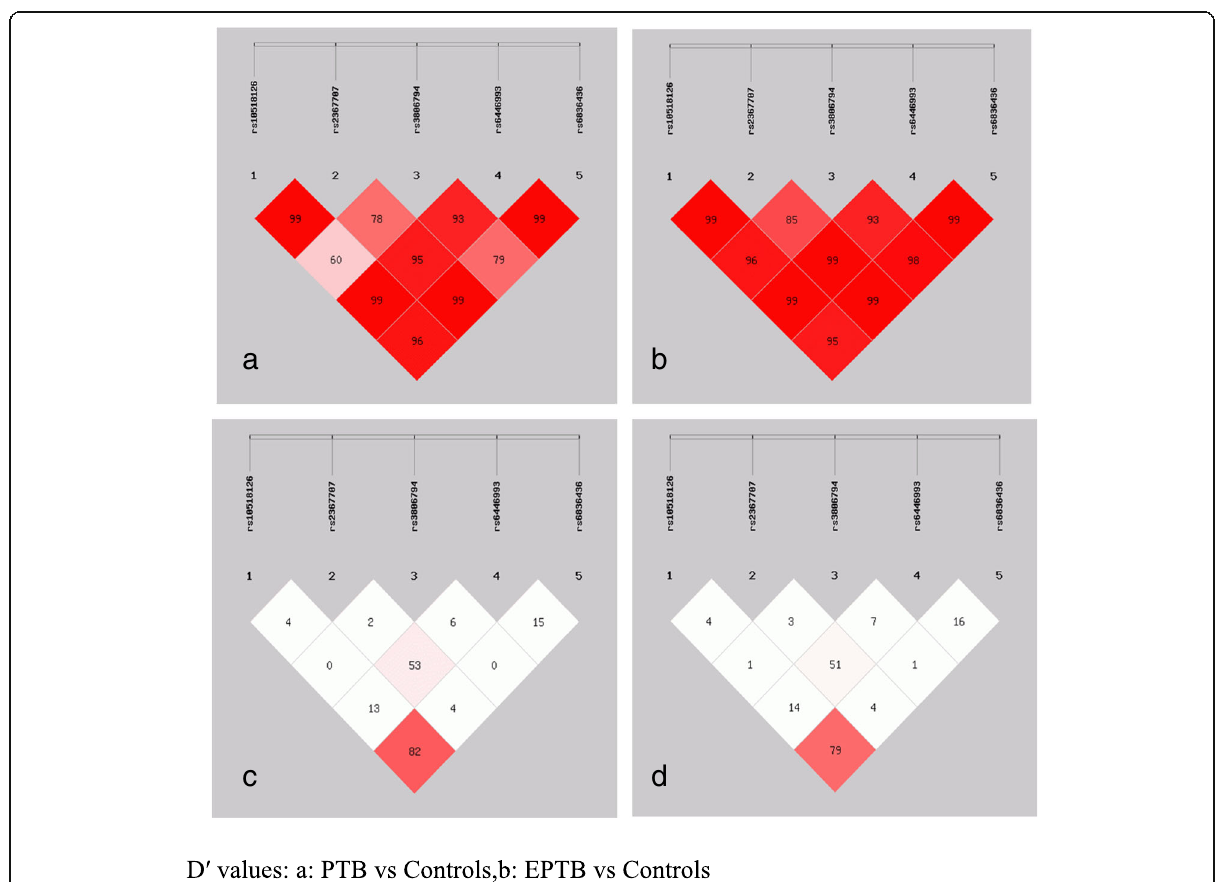
Fig. 2 Linkage disequilibrium (LD) structure of SNPs in EREG. D ′ values (%) and r 2 are indicated on squares. Pairwise values are color coded: high values are dark, low values are light. All values were generated using SHEsis software. D ′ values: a PTB vs Controls, b EPTB vs Controls. R 2 values: c PTB vs Controls. d EPTB vs